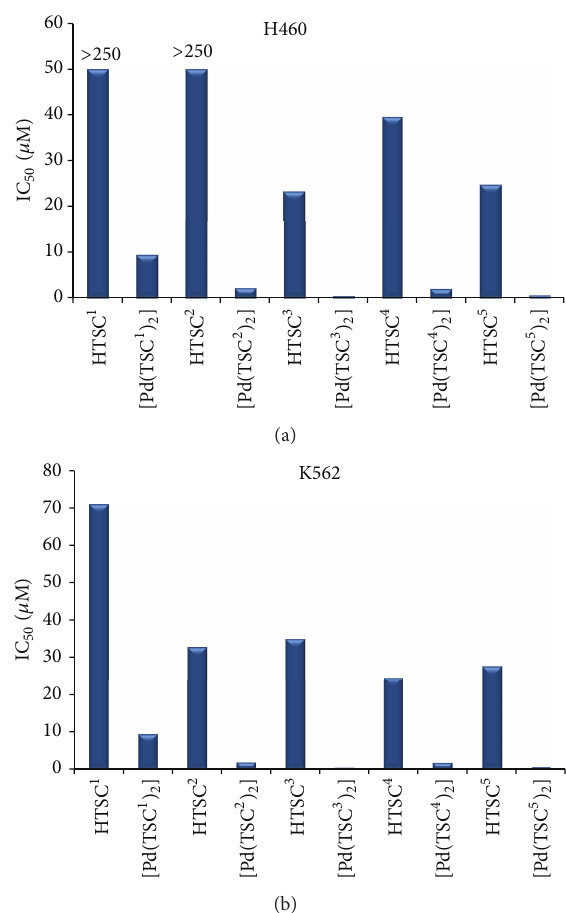
Figure 6: The antiproliferative activity in vitro expressed as IC 50 ( 𝜇 M) values of the ligands HTSC 1 – 5 and palladium(II) complexes [Pd(TSC 1 – 5 ) 2 ]against(a)H460and(b)K562humantumorcelllines after 48 h incubation time.